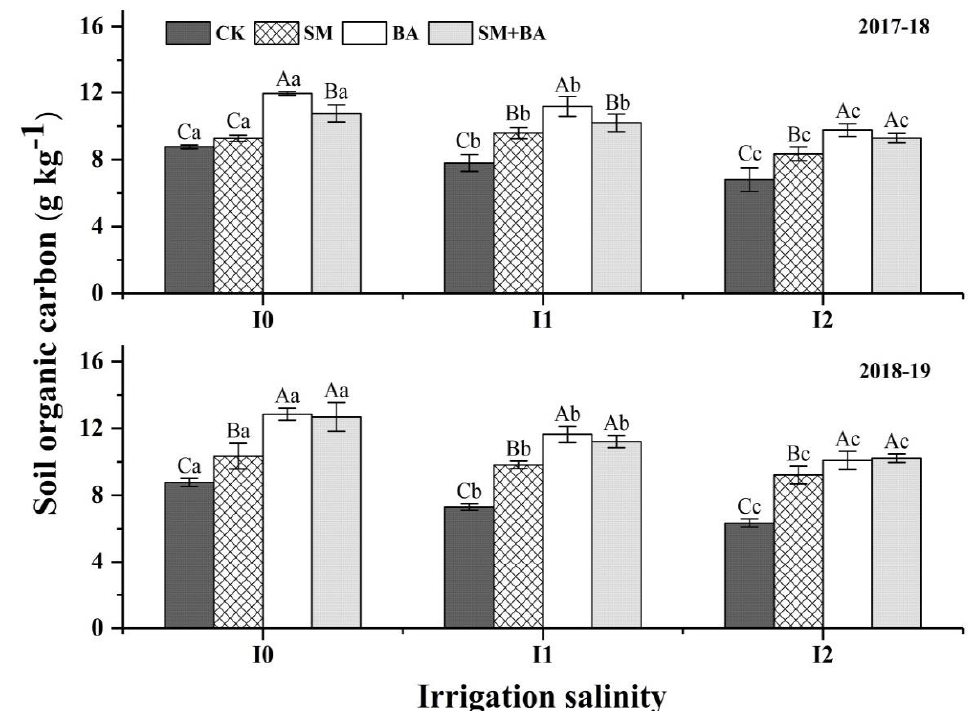
Figure 6. The effects of the straw-returning modes and irrigation water salinity on soil organic carbon (SOC) levels in 2017–2018 and 2018–2019, respectively. The values are means of three replications ± standard deviation. For each growing season, the different uppercase and lowercase letters indicate a significant difference ( p < 0.05) among straw-returning modes (for a given irrigation regime) and irrigation water salinity levels, respectively. CK: no straw-returning, SM: straw mulching, BA: biochar amendment, SM+BA: straw mulching with biochar amendment; I0, I1, and I2 indicate irrigation salinity levels of 0.47 dS m −1 , 3.25 dS m − 1 , and 6.75 dS m −1 , respectively.